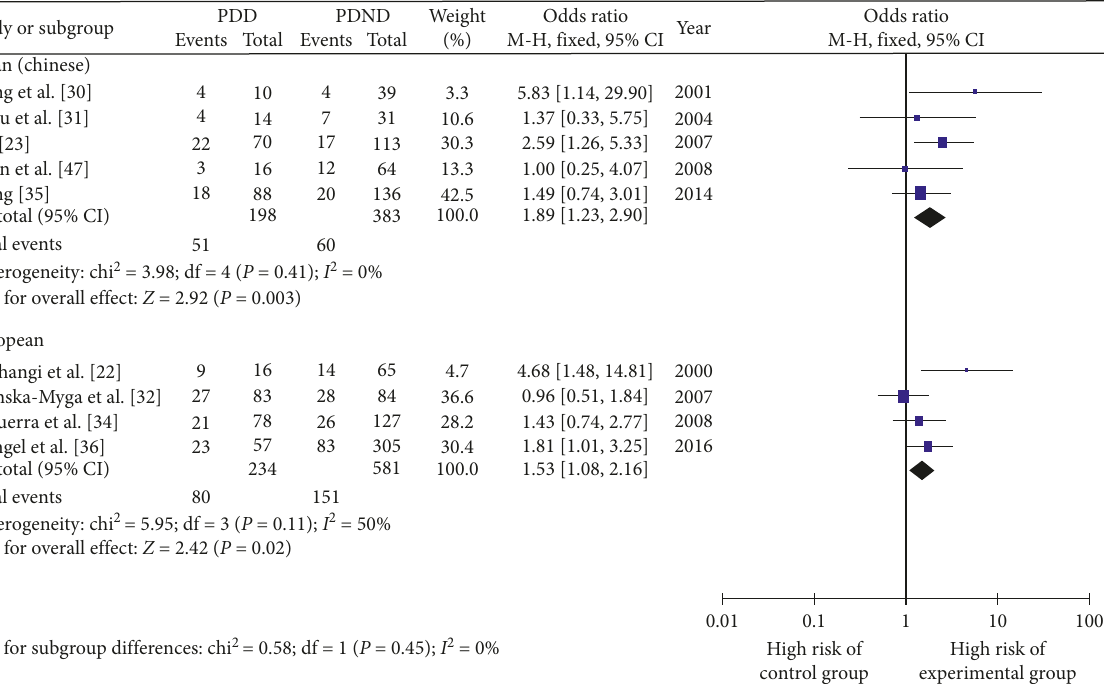
Figure 7: Forest plot for the influence of regional distribution on Parkinson’s disease dementia onset risk of ε 4+ patients.